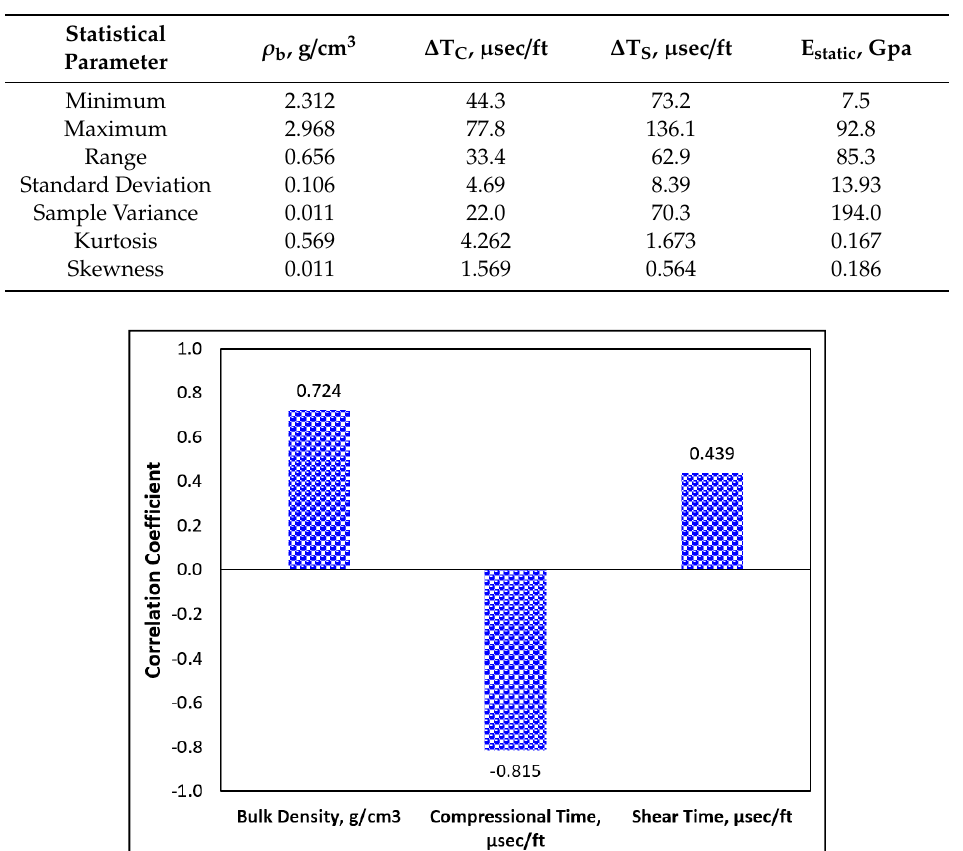
Figure 1. The relative importance of the training dataset input parameter.